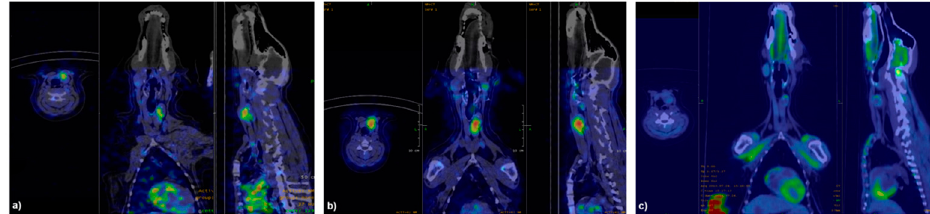
Figure 3. 99m Tc-TR1401 ( a ), 99m Tc-TR1402 ( b ), and [ 18 F]FDG ( c ) PET-CT images in dog 1 with a spontaneous trabecular/solid follicular thyroid cancer. Dog was hyperthyroid and showed high tumor uptake of 99m Tc-TR1401 and 99m Tc-TR1402. This dog showed the lowest FDG uptake in the tumor. Figure 4. 99m Tc-TR1401 ( a ), 99m Tc-TR1402 ( b ), and [ 18 F]FDG ( c ) PET-CT images in dog 4 with a spontaneous trabecular/solid follicular thyroid cancer. Images clearly show high tumor uptake of 99m Tc-TR1401 and 99m Tc-TR1402 (similar to the dog in Figure 3). This dog showed the highest FDG uptake in the tumor.